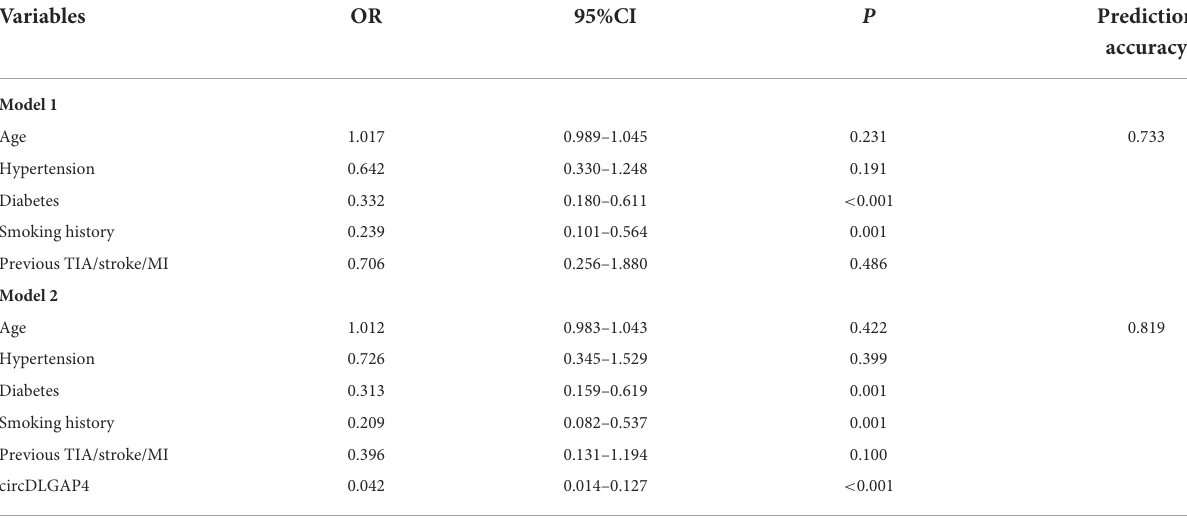
TABLE 3 The circDLGAP4 level in the multivariable logistic regression model for AIS diagnosis prediction.